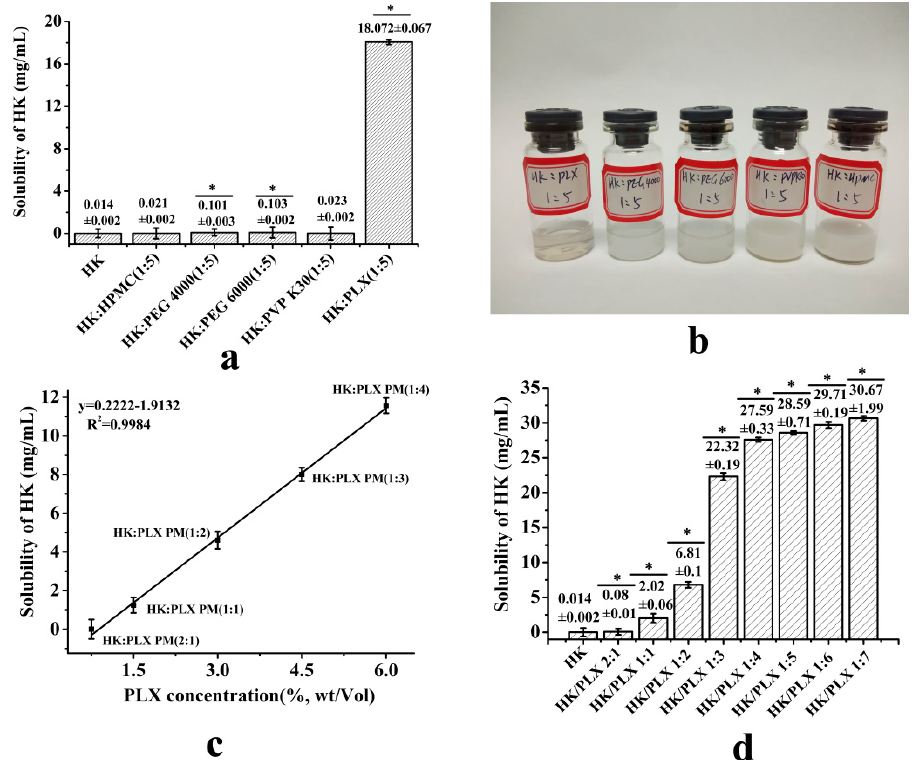
Figure 2. ( a ) The solubility of the di ff erent solid dispersions of honokiol (HK) (* p < 0.05). ( b ) Photographs of di ff erent solid dispersions in water. ( c ) Drug solubility as a function of poloxamer-188 (PLX) concentration in HK–PLX physical mixture. ( d ) The solubility of HK SD with di ff erent proportions of PLX (* p < 0.05).